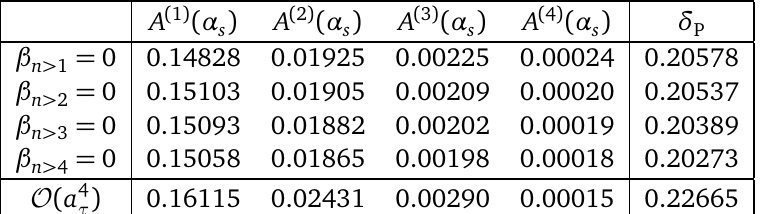
) ( n ≤ 4) at different β -function approximations, s = (cid:80) 4 ) , for a ≡ α ( m 2 ) /π = 0.11. K A ( n ) ( α τ τ n s s P n = 1